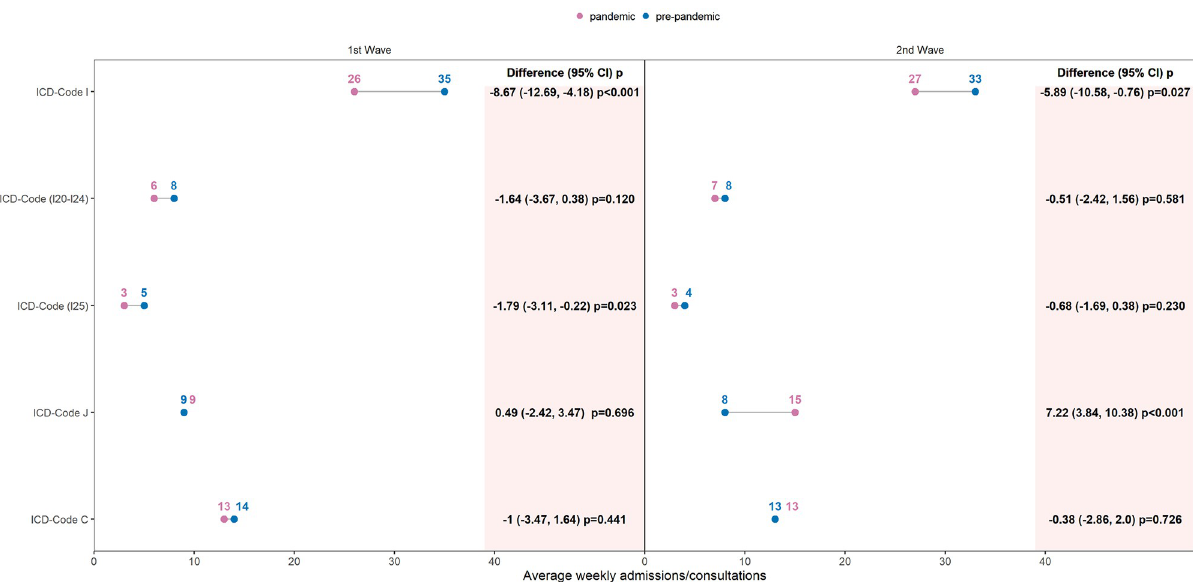
Fig 3. Yearly changes in pandemic year, 2020, weekly admissions by diagnosis, compared to pre-pandemic years (2017–2019). Connected dots represented the average number of weekly admissions by International Classification of Diseases–10th (ICD) code group in each period, pandemic and pre-pandemic, during the two pandemic waves. The differences between the two averages and 95% bootstrap Confidence Interval (CI) with p-values (robust t-test) were reported in columns. 1st Wave: calendar weeks (10–24); 2nd Wave: calendar weeks (39–53).